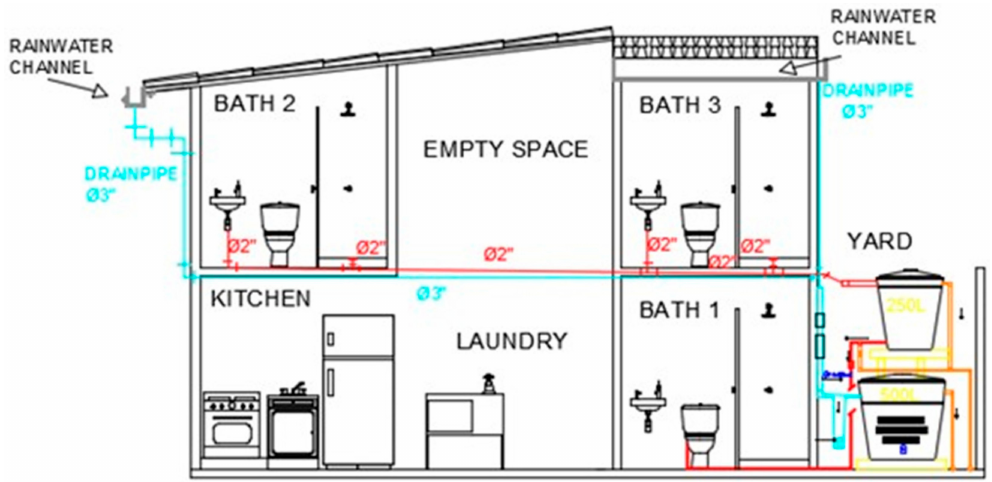
Figure 6. Scheme for alternative 3: GWR and